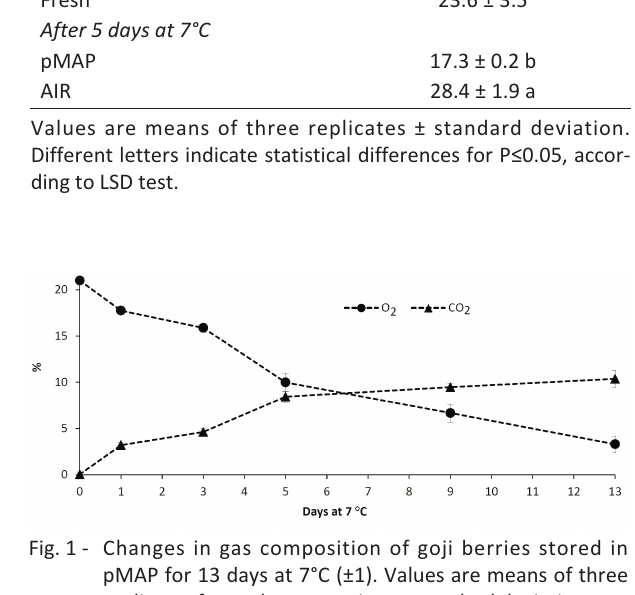
deviation.Table 1 ­ Respiration rate of goji berries at harvest and after 5 days at 7°C (±1) in pMAP or AIR